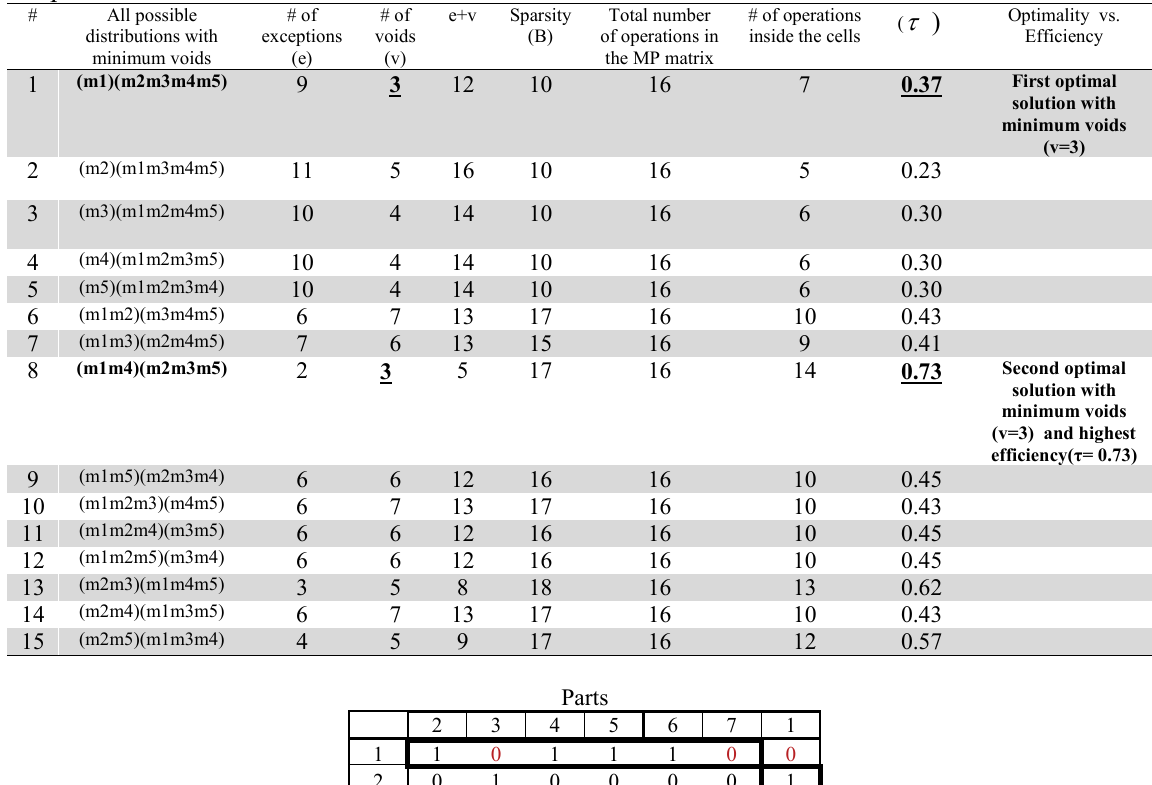
All possible distributions to form 2-cells from 5-machines with minimum voids